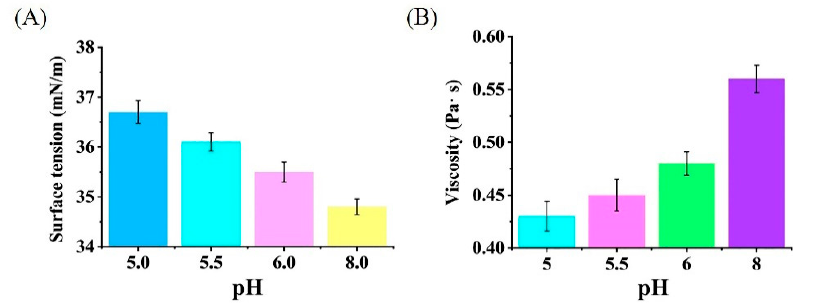
Figure 7. Characterizing the effects of pH on surface tension ( A ) and viscosity ( B ) of rhamnolipid fermentation broths.